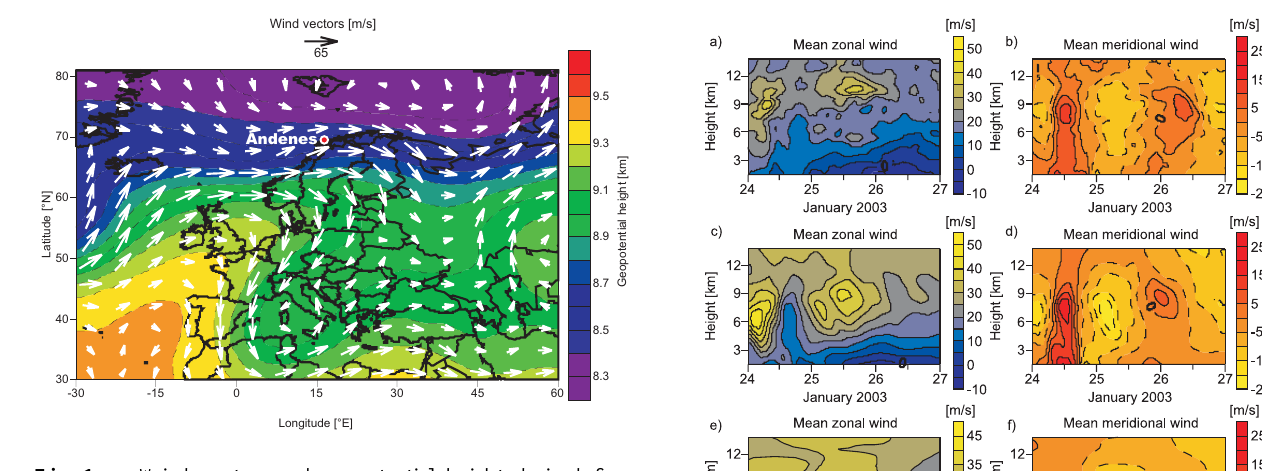
Fig. 1. Wind vectors and geopotential height derived from ECMWF analysis for the 300hPa level at 24 January 2003, 12:00 UT.